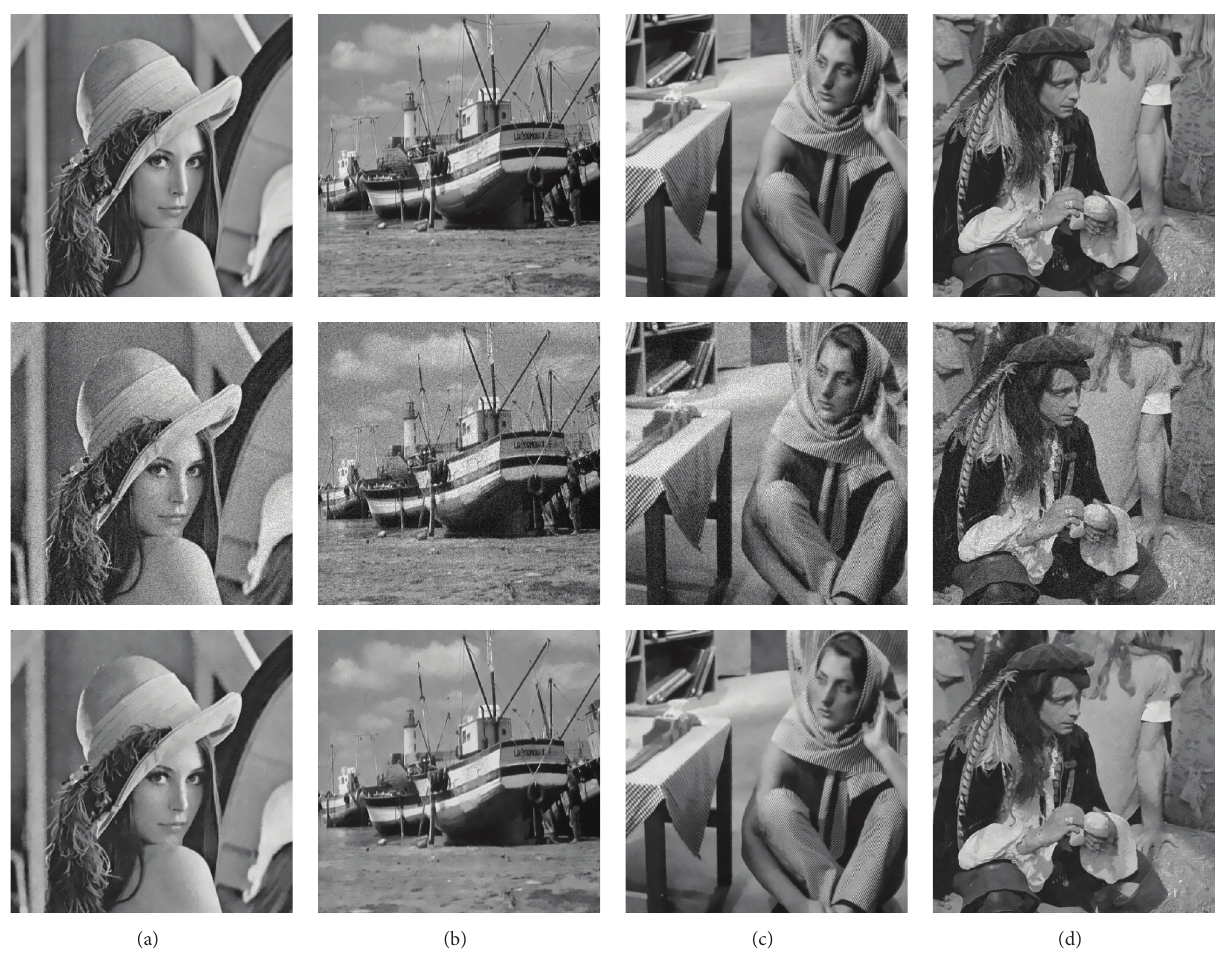
Figure 1: Noise-free images and denoising results with 𝜎 = 20 . (a), (b), (c), and (d) are Lena , Boat , Barbara , and Man , respectively. The first row is the noise-free image. The second row is the noisy image corrupted by additive zero-mean Gaussian noise with 𝜎 = 20 , and third row is the denoising result by the proposed